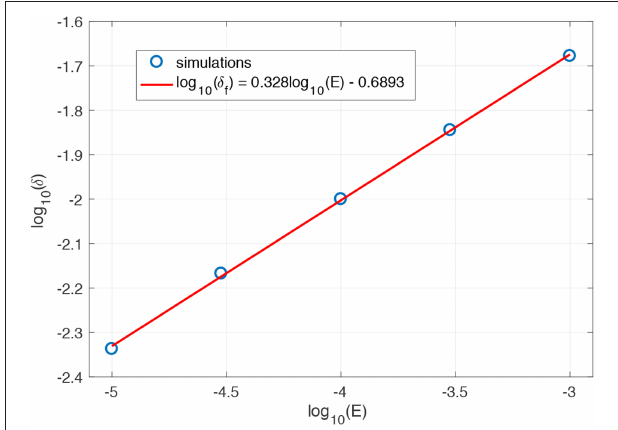
FIGURE 3 | Mean thickness of the chemical plumes measured in the equatorial plane for different values of the Ekman